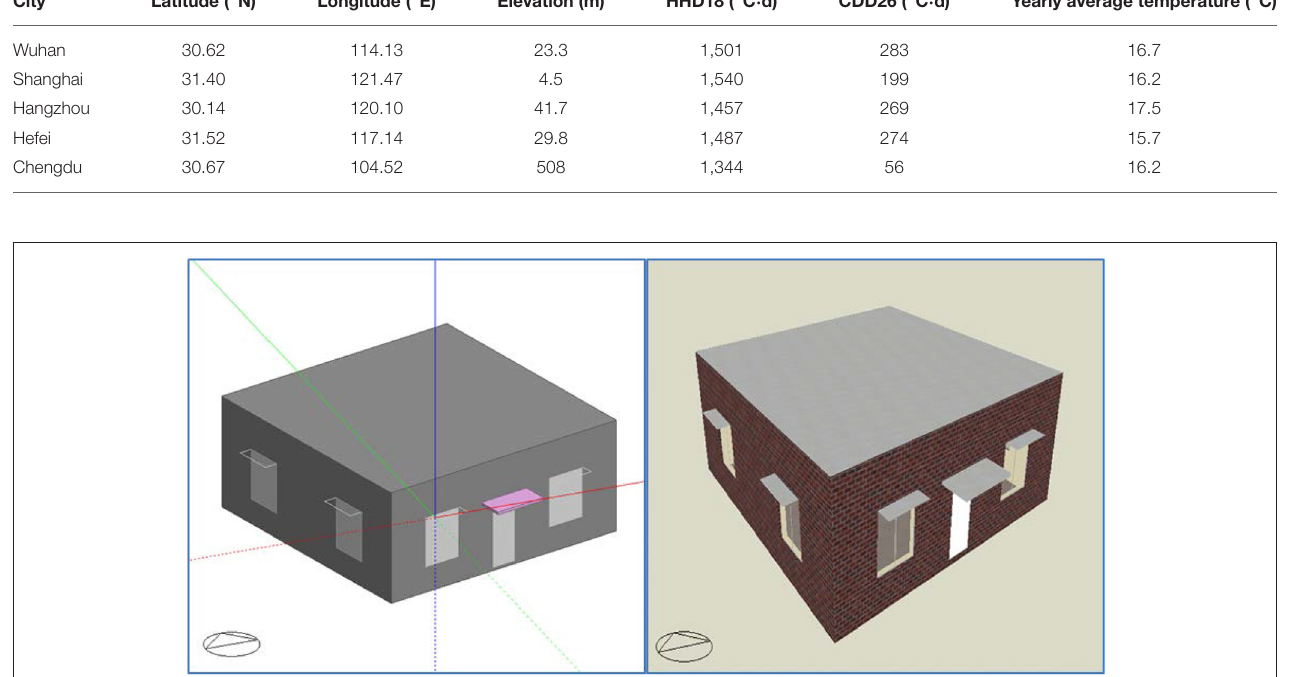
FIGURE 4 | Reference building.